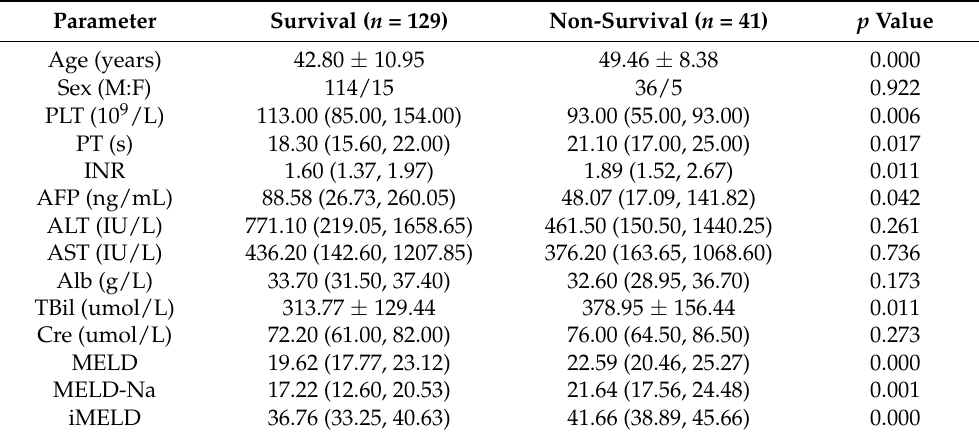
Table 1. Clinical characteristics and outcomes of HBV-ACLF patients.